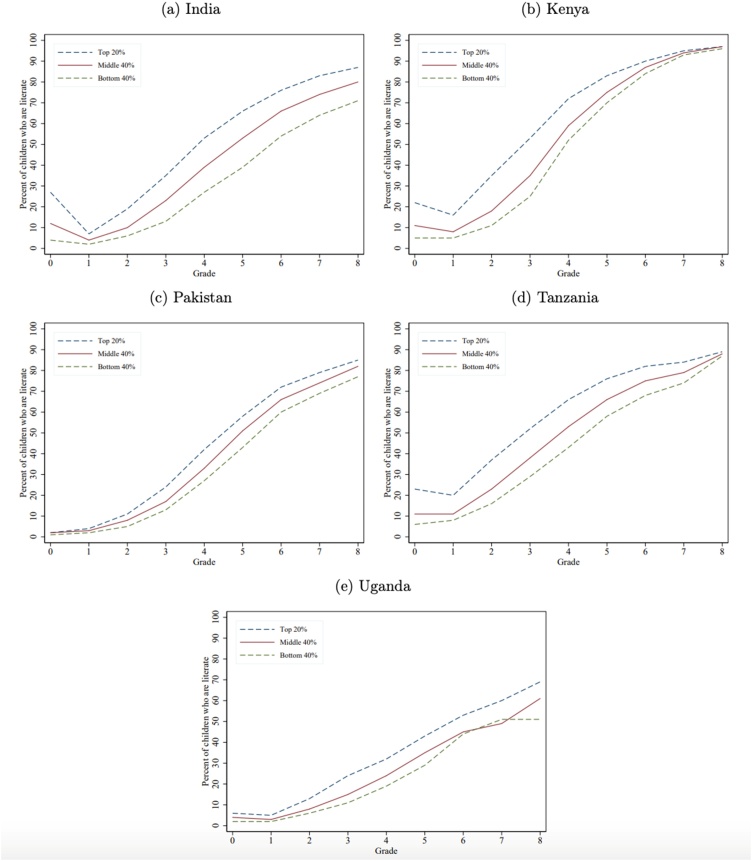
Learning Profiles by Wealth: Local Language (All Ages).